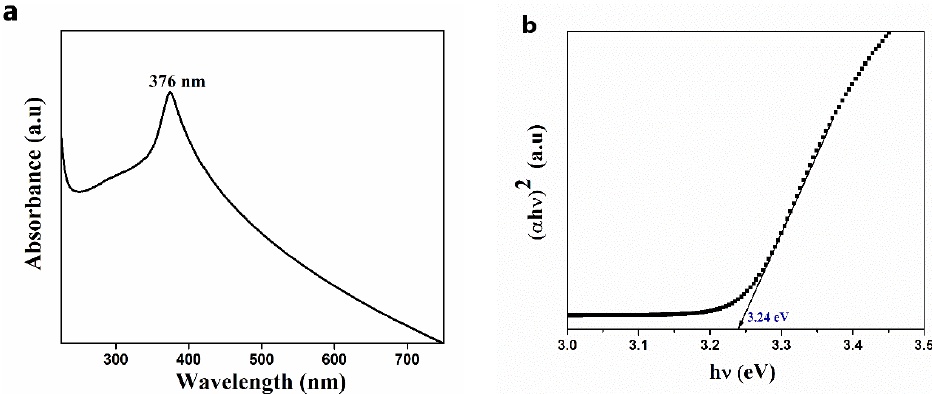
Figure 3. ( a ) The absorption spectrum of ZnO NPs; ( b ) Tauc plot of ZnO NPs.